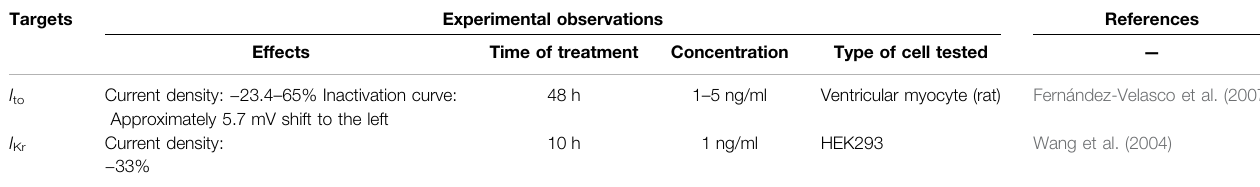
TABLE 1 | The effects of TNF- α on cellular targets. Targets